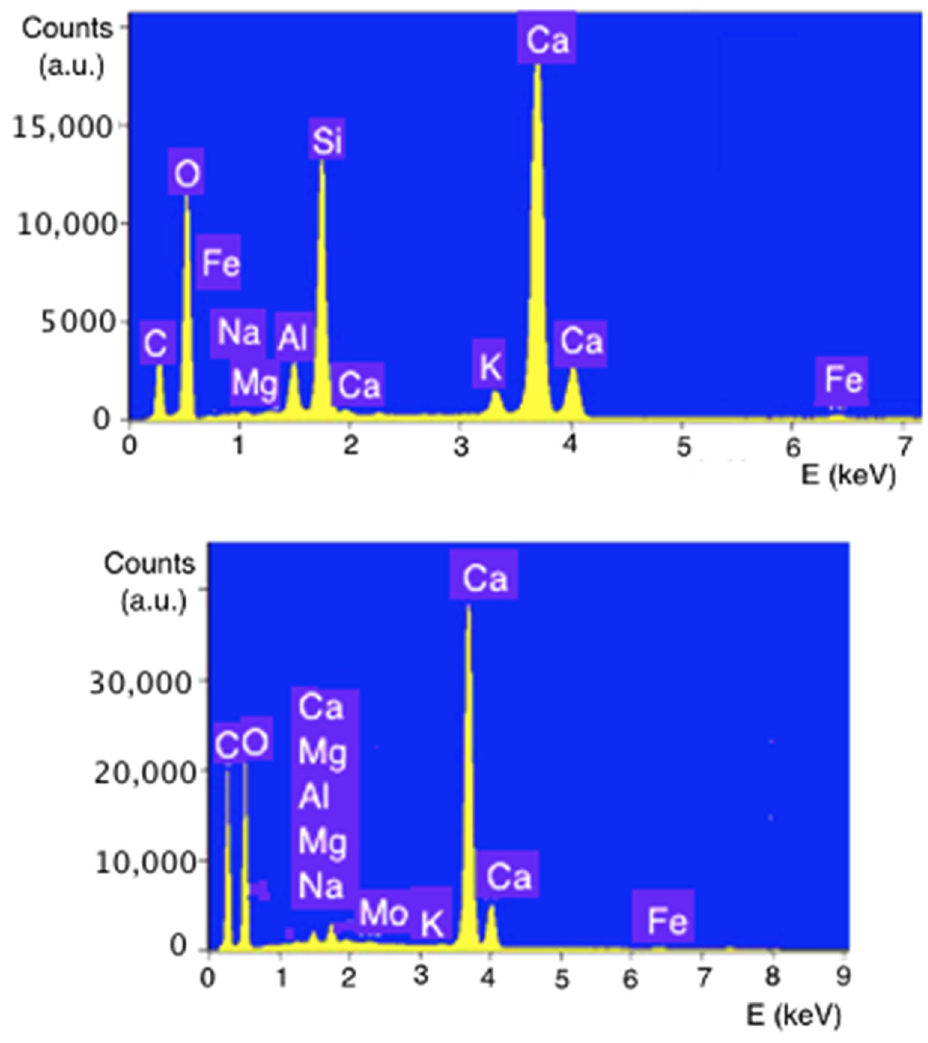
Figure 2. EDS results for substrate and green pigment. Table 2. The EDS compositions for white and green pigments.